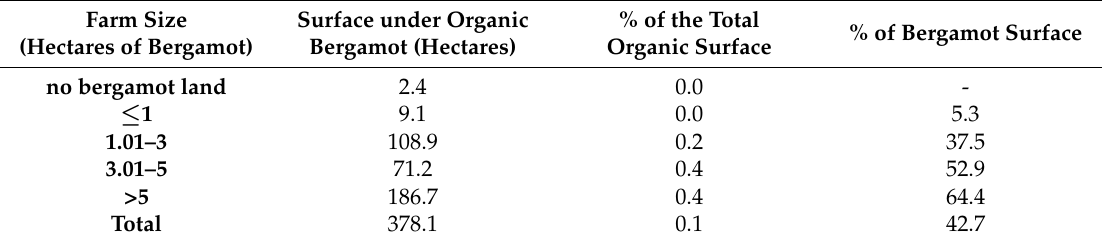
Table 6. Surface under organic production by farm size in the study area. Farm Size Surface under Organic (Hectares of Bergamot) Bergamot